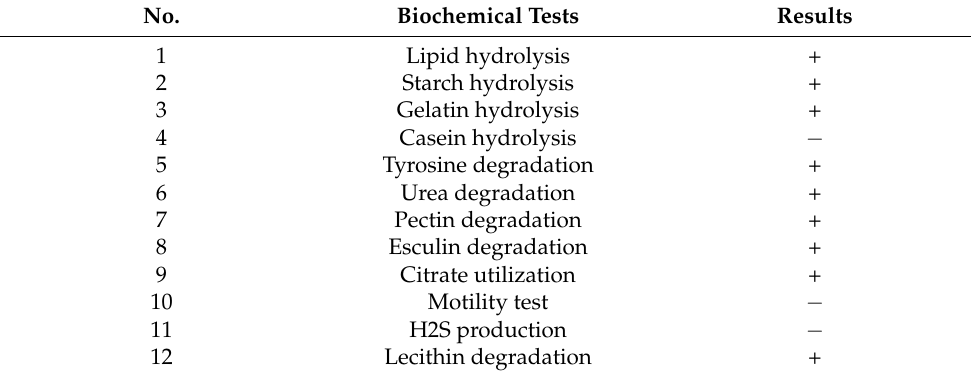
Table 3. Biochemical characteristics of isolate MK-104.